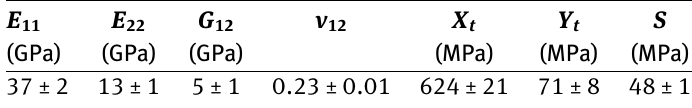
Table 1: Mechanical properties of UD GFRP composite